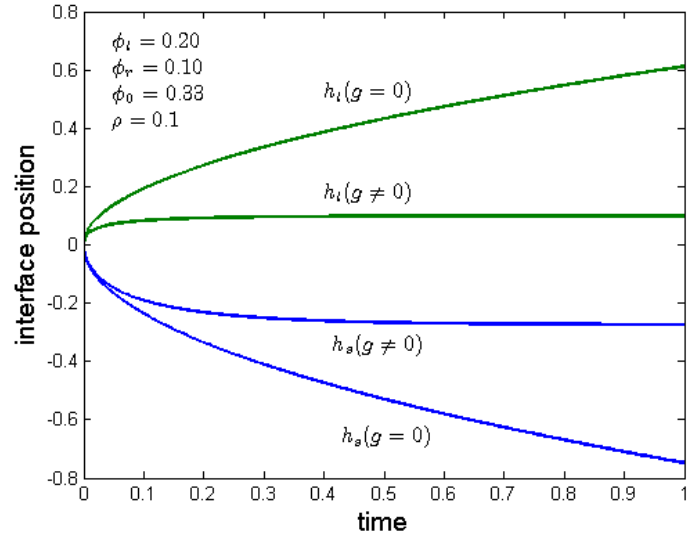
Figure 8. The dynamics of capillary rise for both zero and non–zero gravity